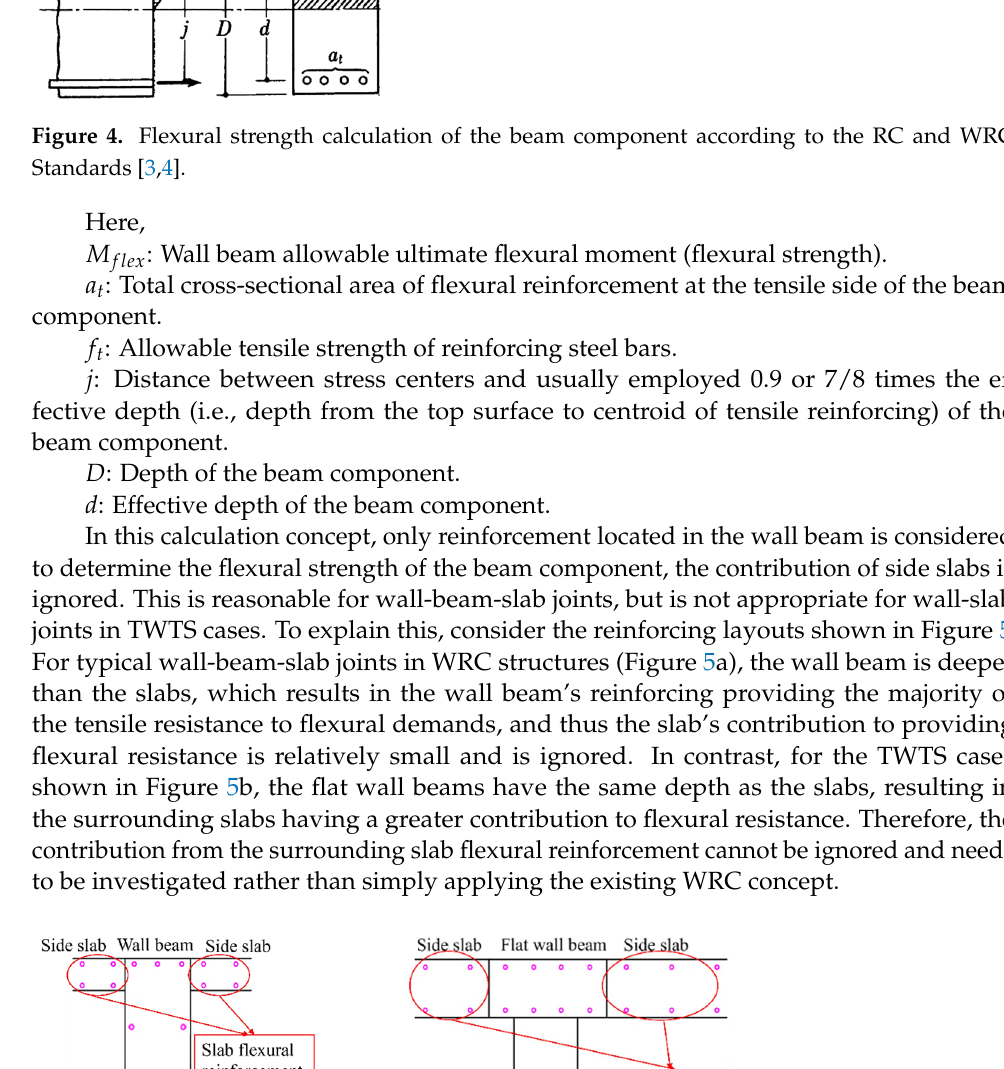
Figure 5. Bending moment transferring around walls: ( a ) in WRC case, ( b ) in TWTS case.